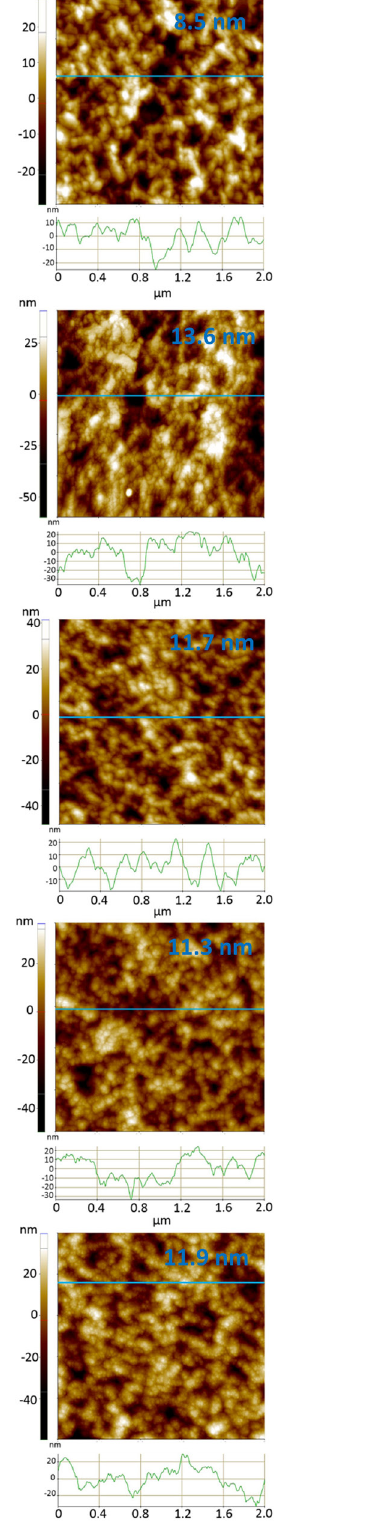
Figure 3. AFM images, 2 2 , mx m µ